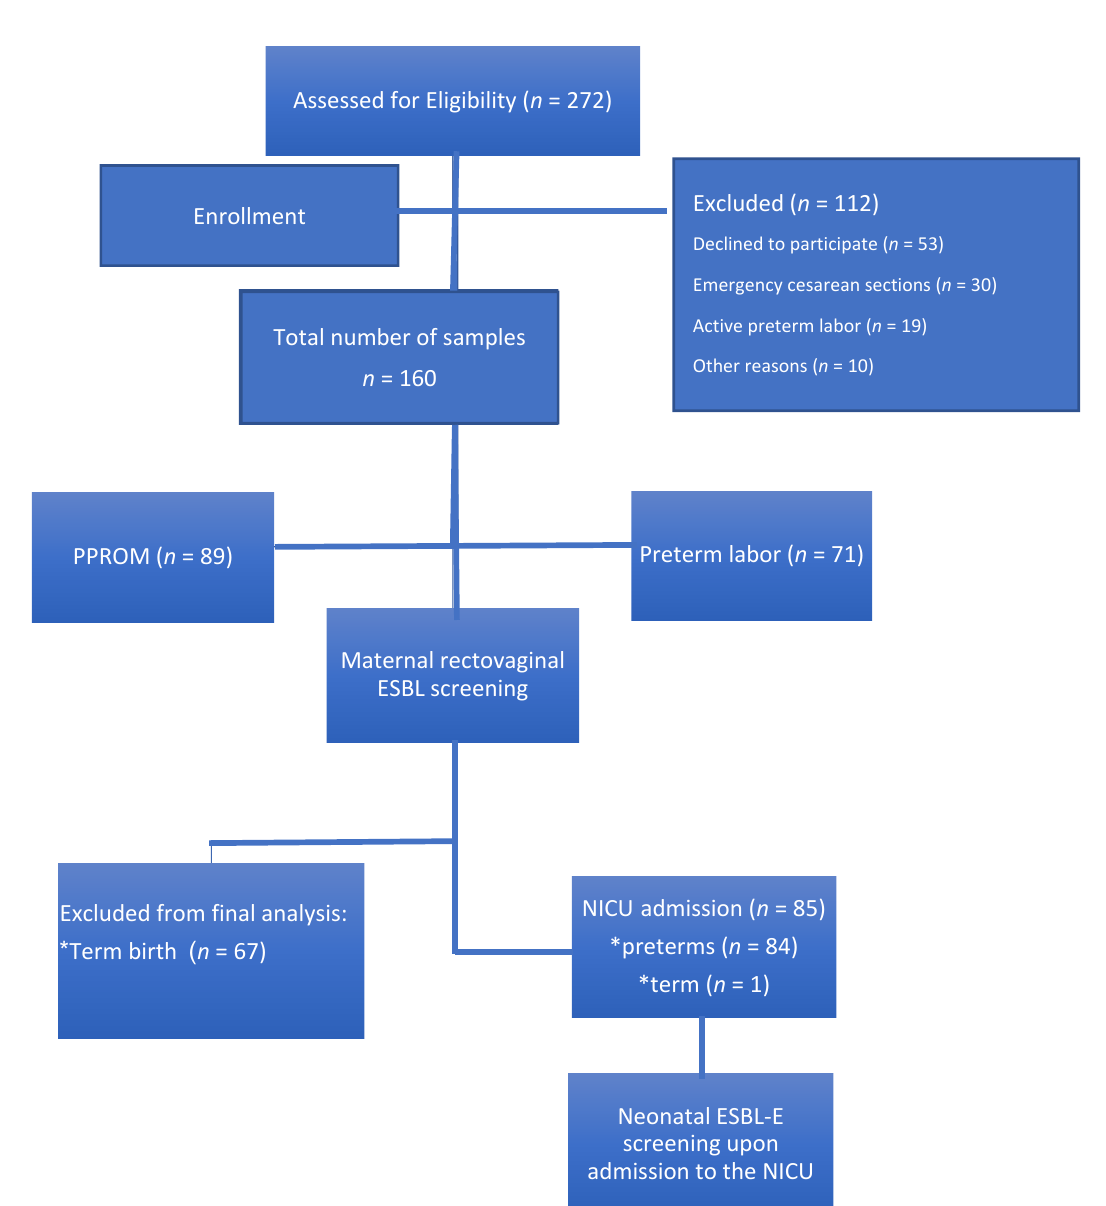
Figure 1. Study population. ESBL-E: extended-spectrum beta-lactamase-producing Enterobacteriaceae ; NICU: neonatal in- tensive care unit; PPROM: preterm premature rupture of membranes.